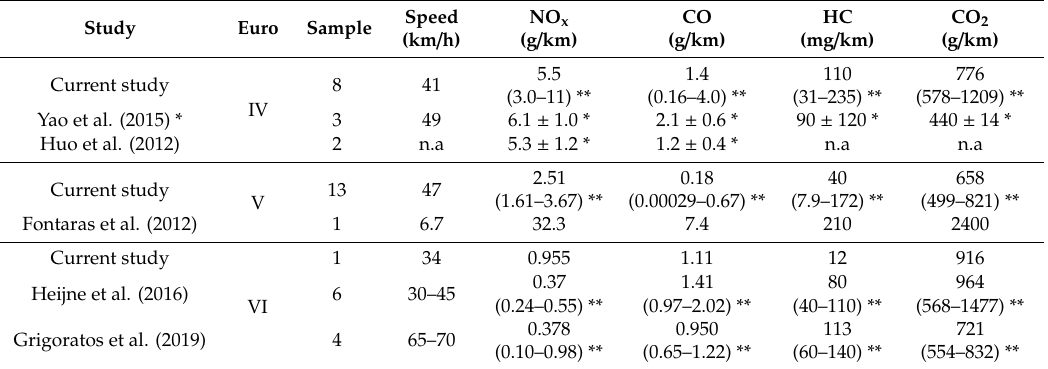
Table 4. Comparison of the results of this study to the results of similar